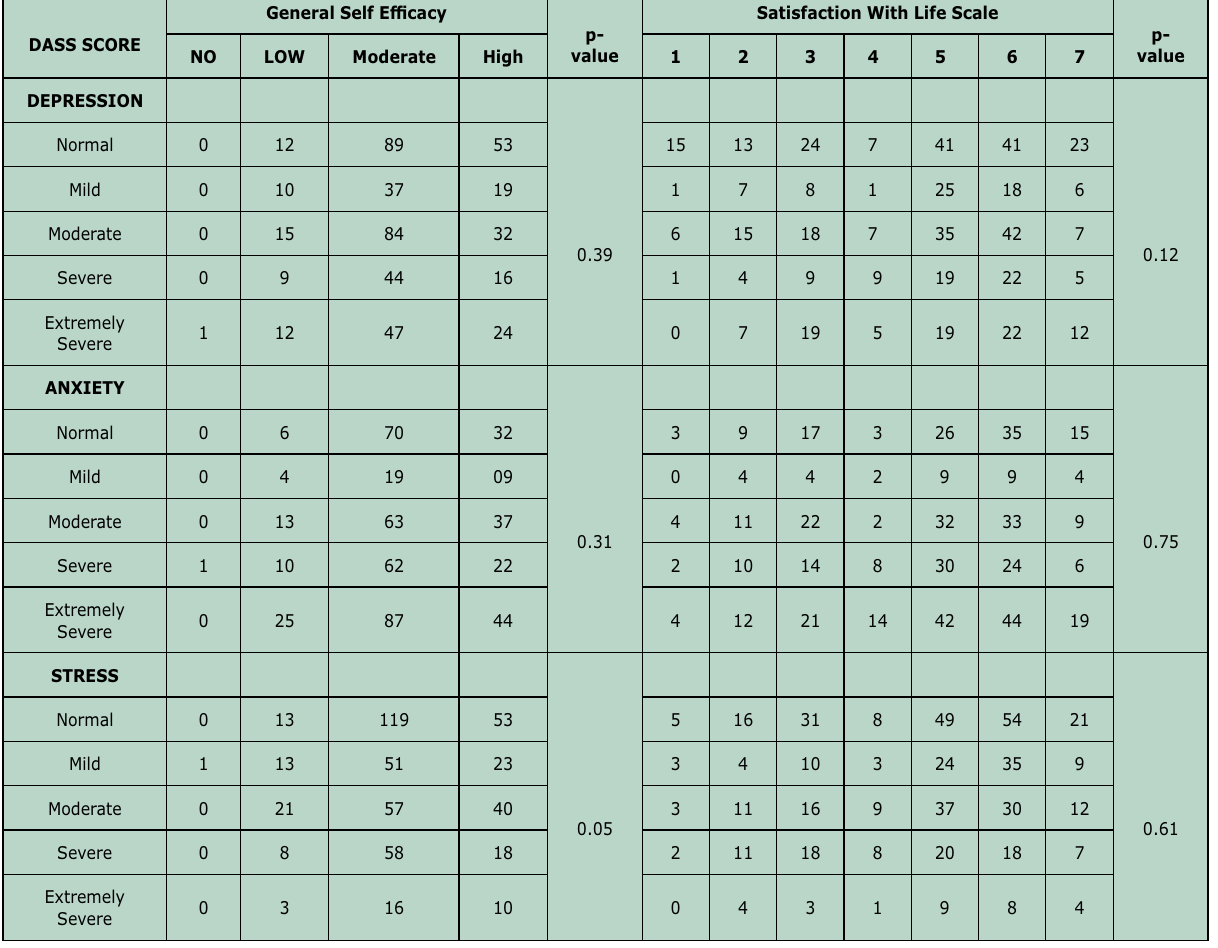
Figure-III: Association of Stress score with academic year. 2 x = 41.31, df= 16, p= 0.05 Table-II: Association of DASS score with General Self Efficacy (GSE) and Satisfaction With Life Scale (SWLS). (In SWLS, 1 is Extremely Dissatisfied, 2 is Dissatisfied, 3 is Slightly Dissatisfied, 4 is Neutral, 5 is Slightly Satisfied, 6 is Satisfied, 7 is Extremely